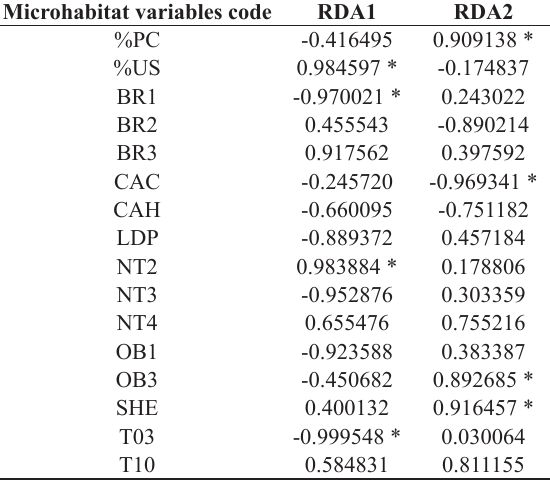
Pearson linear correlations between microhabitat variables and the redundancy axes. RDA1 = first redundancy axis; RDA2 = second redundancy axis. See text for the